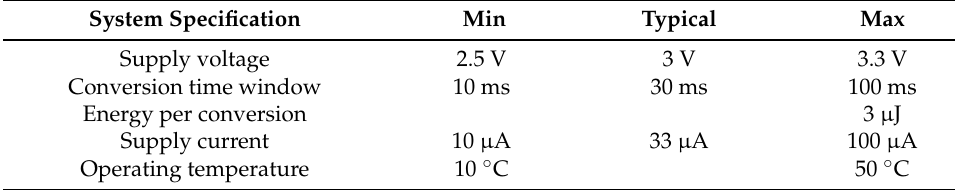
Table 1. ANTIGONE ASIC